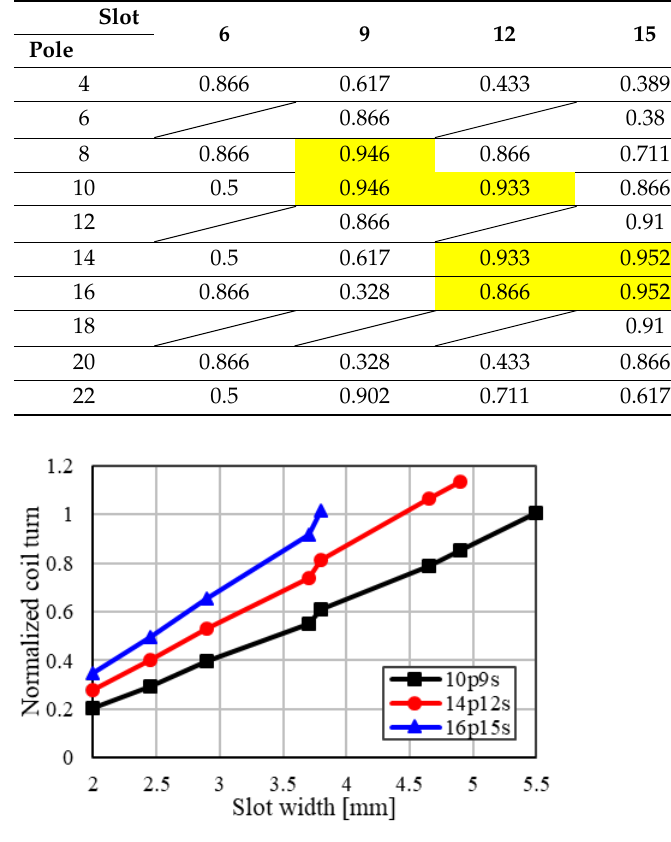
Table 4. Winding factor for each number of poles and slots in concentrated winding.